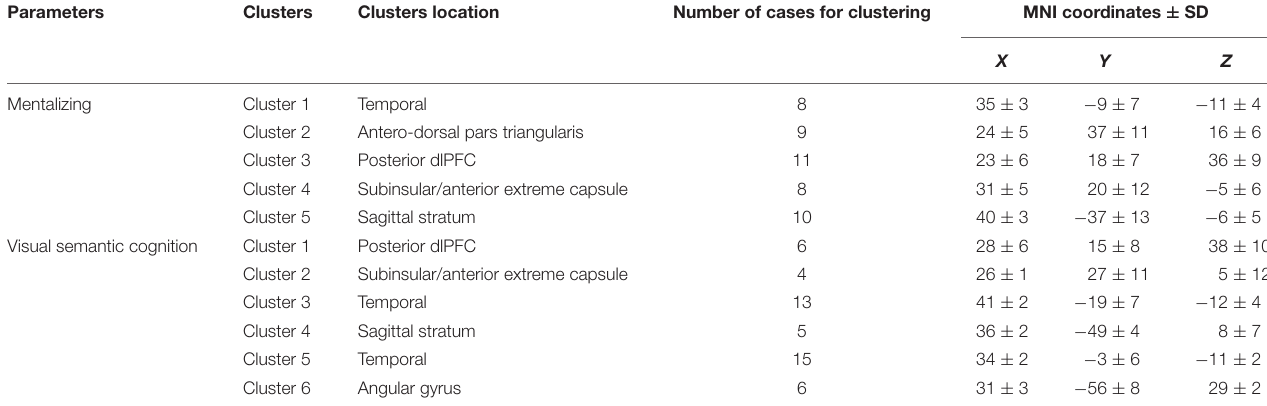
TABLE 2 | Cluster coordinates.